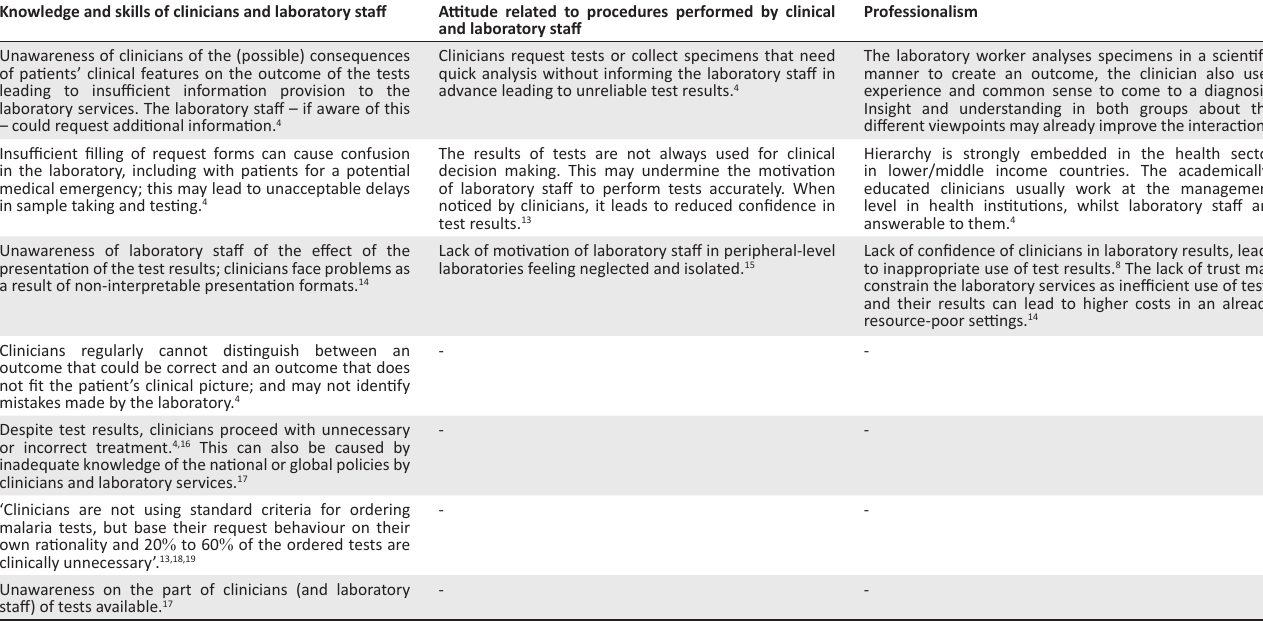
TABLE 3: Evidence found in peer-reviewed and grey literature on personal factors that have an influence on the interface between clinicians and laboratory staff. Knowledge and skills of clinicians and laboratory